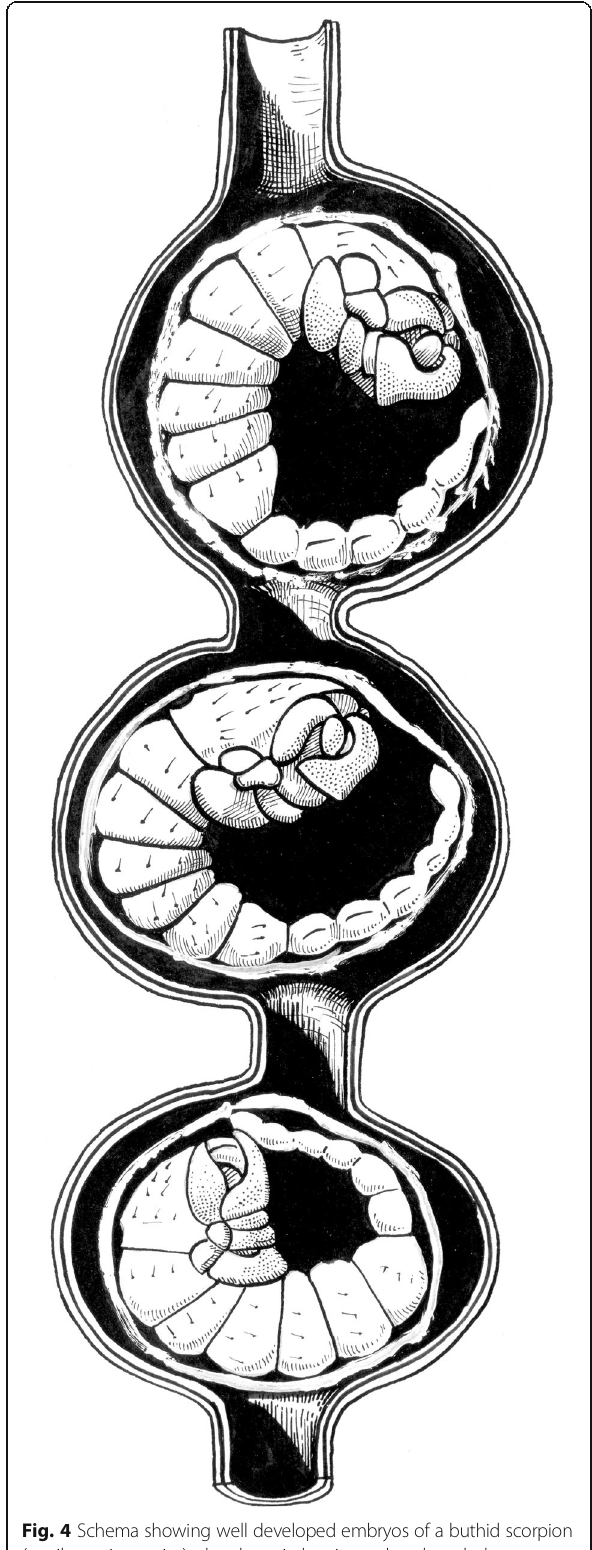
Fig. 4 Schema showing well developed embryos of a buthid scorpion (apoikogenic species), already entirely migrated to the